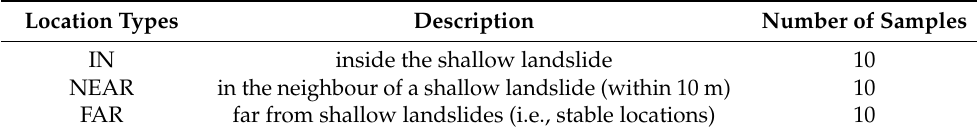
Figure 9. Root sample acquisition field strategy adopted during the survey. Root samples acquired inside (“IN”), near (“NEAR”) and far (“FAR”; <1 km) from shallow landslide locations (the latter detected using a landslide inventory) [70]. Table 3. Number of samples according to the sampling scheme adopted in this